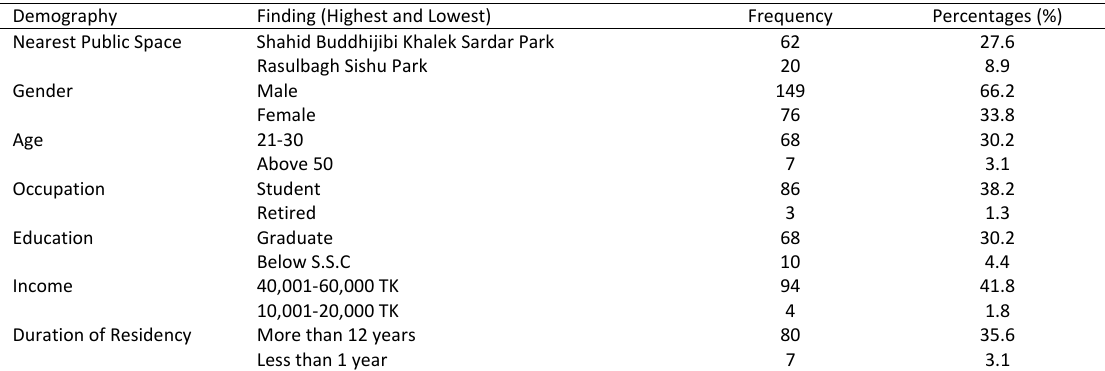
Table 2: summary of respondents’ background